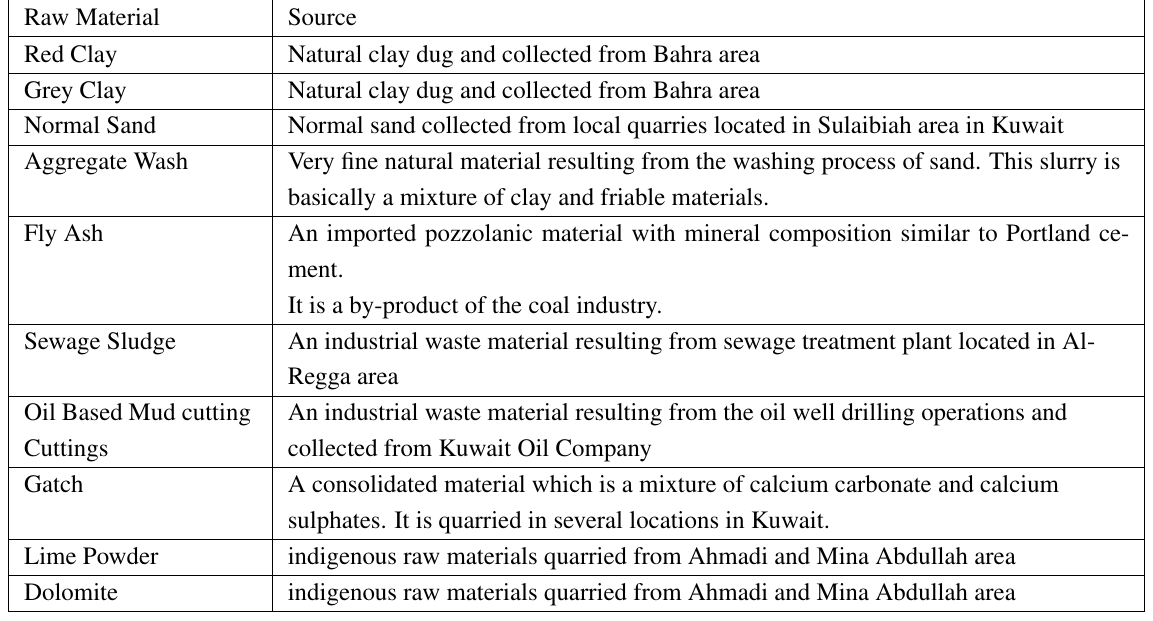
Table 2. Raw materials investigated for the production of